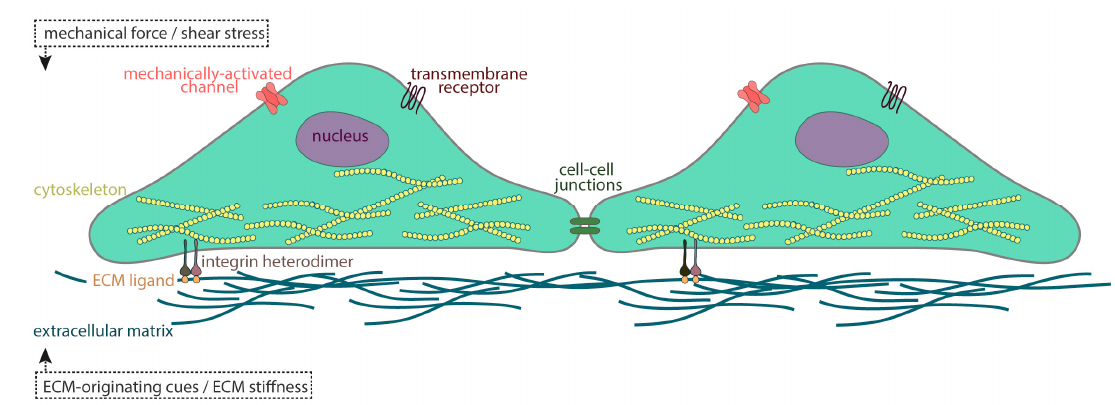
Figure 2. Integration of external stimuli. The perception and interpretation of external signals starts at the cell membrane. Cells sense changes in their surface parameters through transmembrane receptors, ion or cell–cell junctional channels. Sensing of external cues originating from the extracellular matrix (ECM), takes place in specialized sites of interaction between the ECM and the membrane.